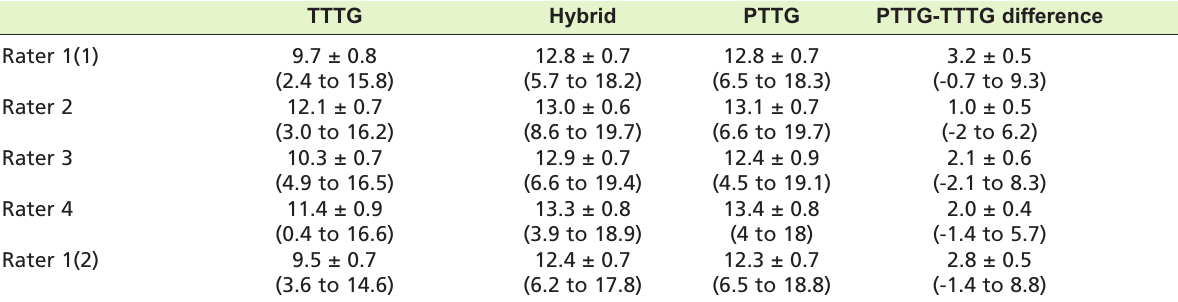
Mean TTTG, hybrid PTTG and PPTG distances for the PFI group for each Table III: